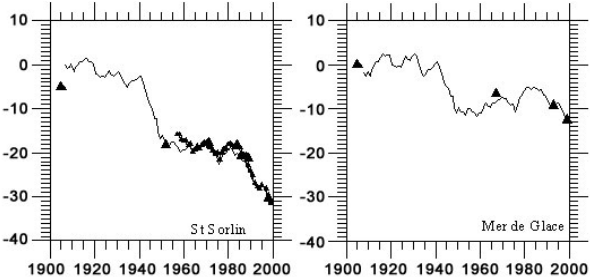
Figure 1 : Cumulative specific net balance (m water-equivalent) from reconstruction (solid Figure 1. Cumulative specific net balance (m water-equivalent) line), from direct measurements (small triangles) and from maps (large triangles) for two from reconstruction (solid line), from direct measurements (small glaciers in the Alps (Vincent, 2002). triangles) and from maps (large triangles) for two glaciers in the Alps (Vincent,